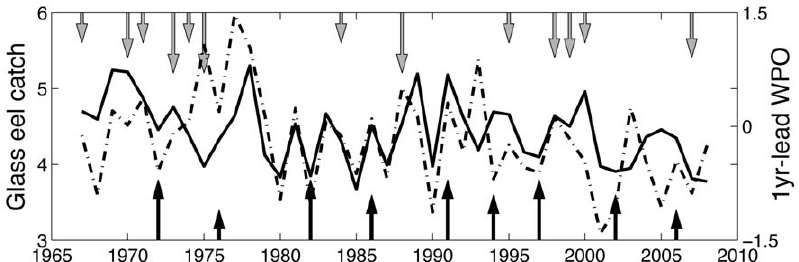
Figure 1. Time series of log 10 (eel catch) (bold line) and 1-year leading summer WPO index (dashed line). The black arrows represent the El Nino years, and the gray arrows represent La Nina years. The length of arrow indicates the strength of the events. The glass eel catches were significantly correlated with summer WPO with 1-year lag. The responses of eel catches to El Nino events were not clear. doi:10.1371/journal.pone.0030805.g001 PDO (the leading EOF of North Pacific monthly sea surface temperature variability poleward of 20 u N) [7], NPI (the area-